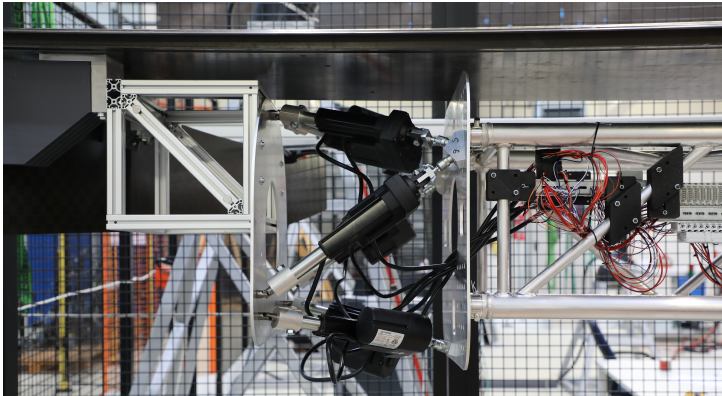
Figure 14. Early version of the end effector with lower stiffness and strength.